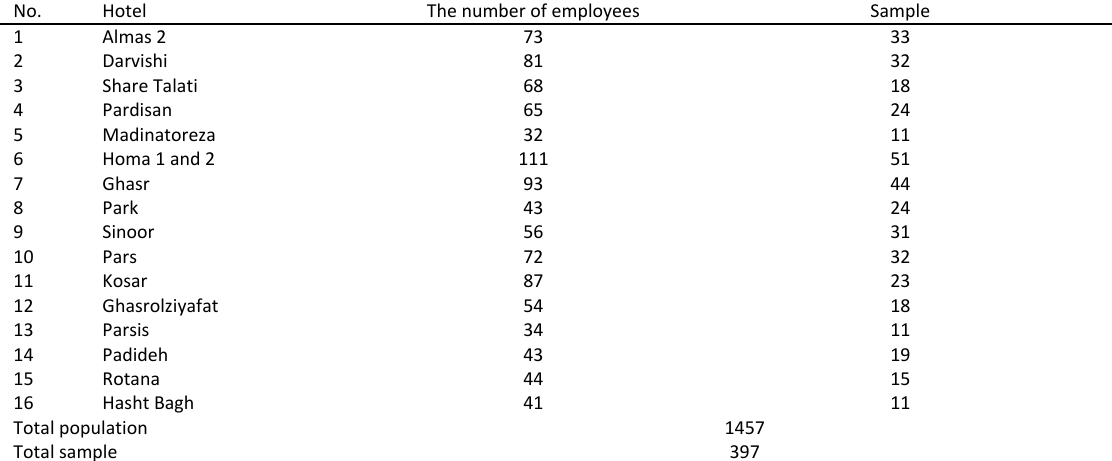
Table 2: Statistical population and a statistical sample of the research No.